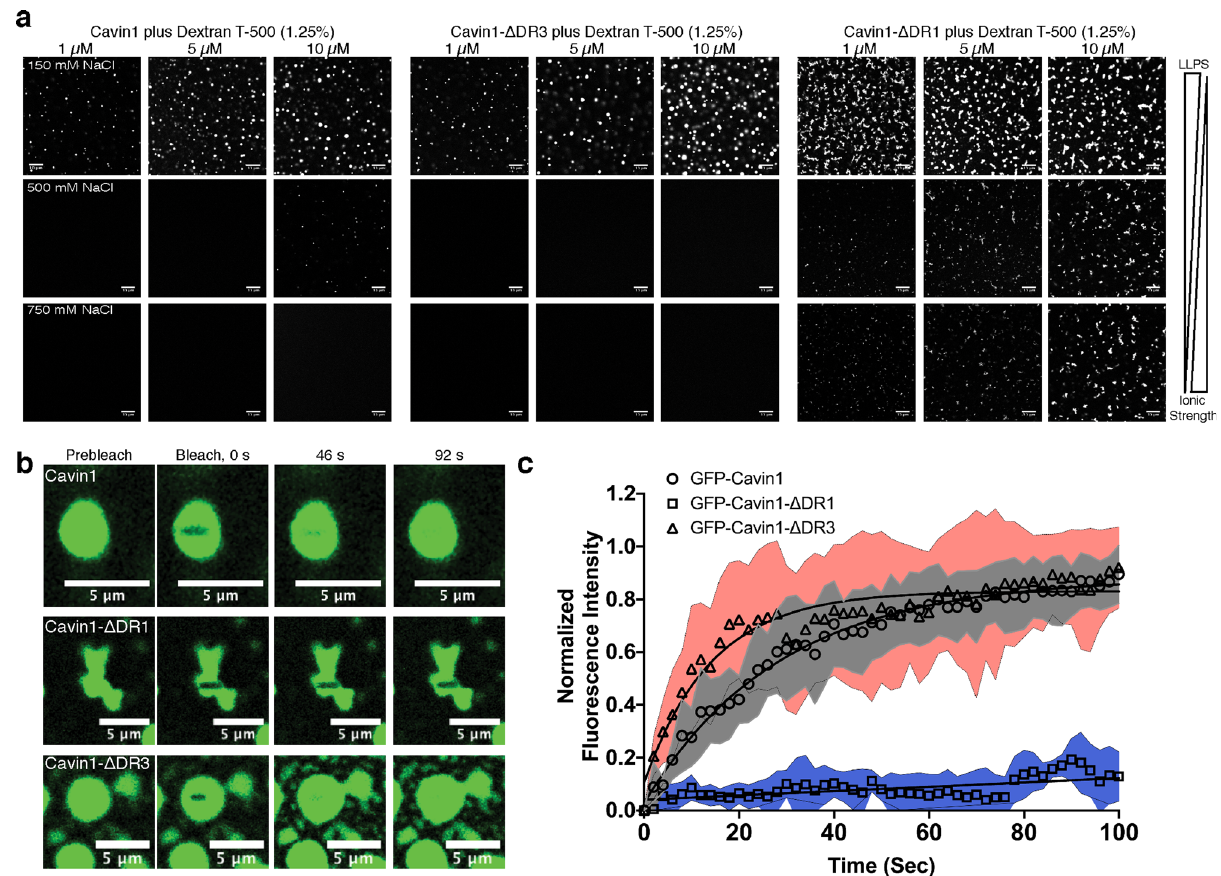
Fig. 2 Cavin1 undergoes liquid – liquid phase separation in vitro. a Liquid – liquid phase separation (LLPS) assays with recombinant Ub-tagged and GFP-tagged Cavin1, Cavin1- Δ DR3 and Cavin1- Δ DR1 at different protein and salt concentrations. Scale bar = 10 μ m. b Fluorescence recovery after photobleaching (FRAP) assay with Cavin1, Cavin1- Δ DR3 and Cavin1- Δ DR1 showing GFP fl uorescence images at increasing times. Scale bar = 5 μ m. c Plot of normalised fl uorescence intensity after photobleaching, n = 7 over three independent experiments, Grey, blue and pink shaded areas around recovery curves represent standard deviation (SD). While Cavin1 and Cavin1- Δ DR3 droplets rapidly exchange with the bulk solution and recover their fl uorescence, Cavin1- Δ DR1 shows virtually no exchange indicating gel formation. Source data for Fig. 2c are provided as a Source Data fi